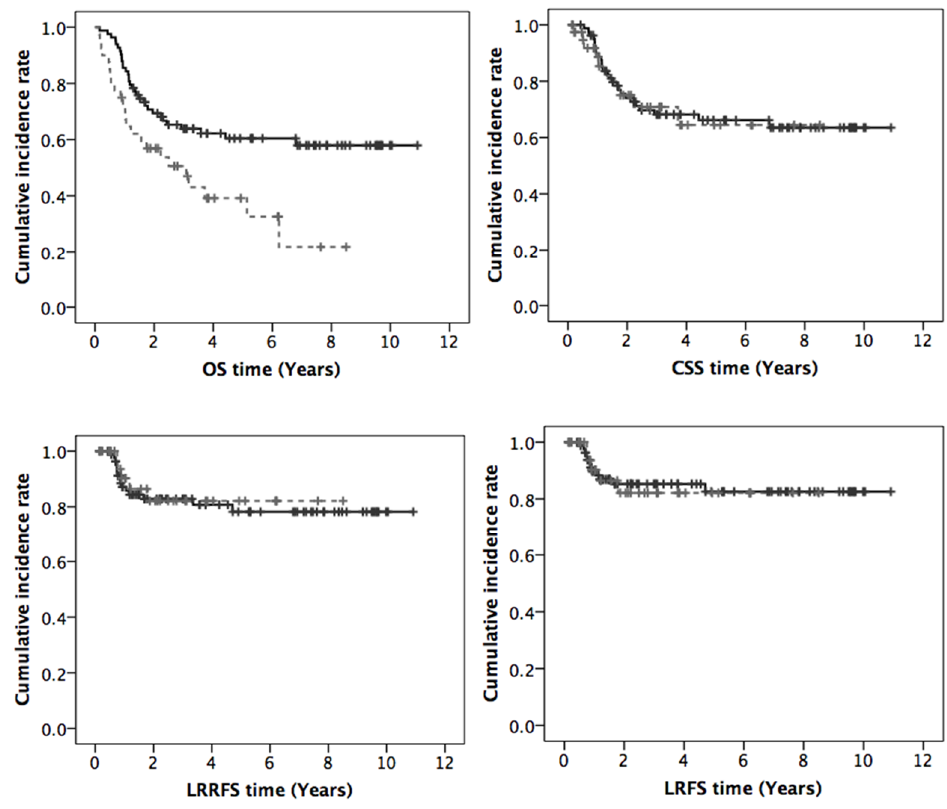
Figure 1. Curves of overall survival (OS), cancer-specific survival (CSS), loco-regional recurrence-free survival (LRRFS), and local recurrence-free survival (LRFS) (black line: age < 70, grey dashed line: age ≥ 70). These treatment outcomes were listed in Table 2. Table 2. Clinical outcomes of OS, CSS, LRRFS, and LRFS.